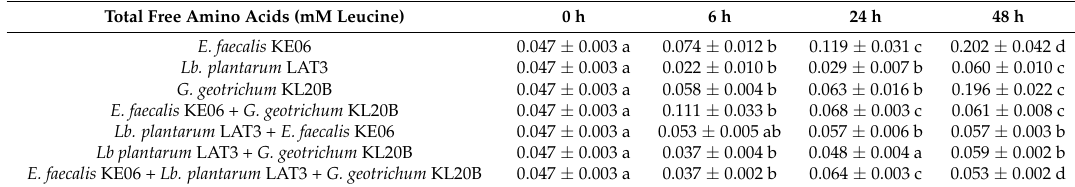
Table 1. Dynamics of total free amino acids production during milk